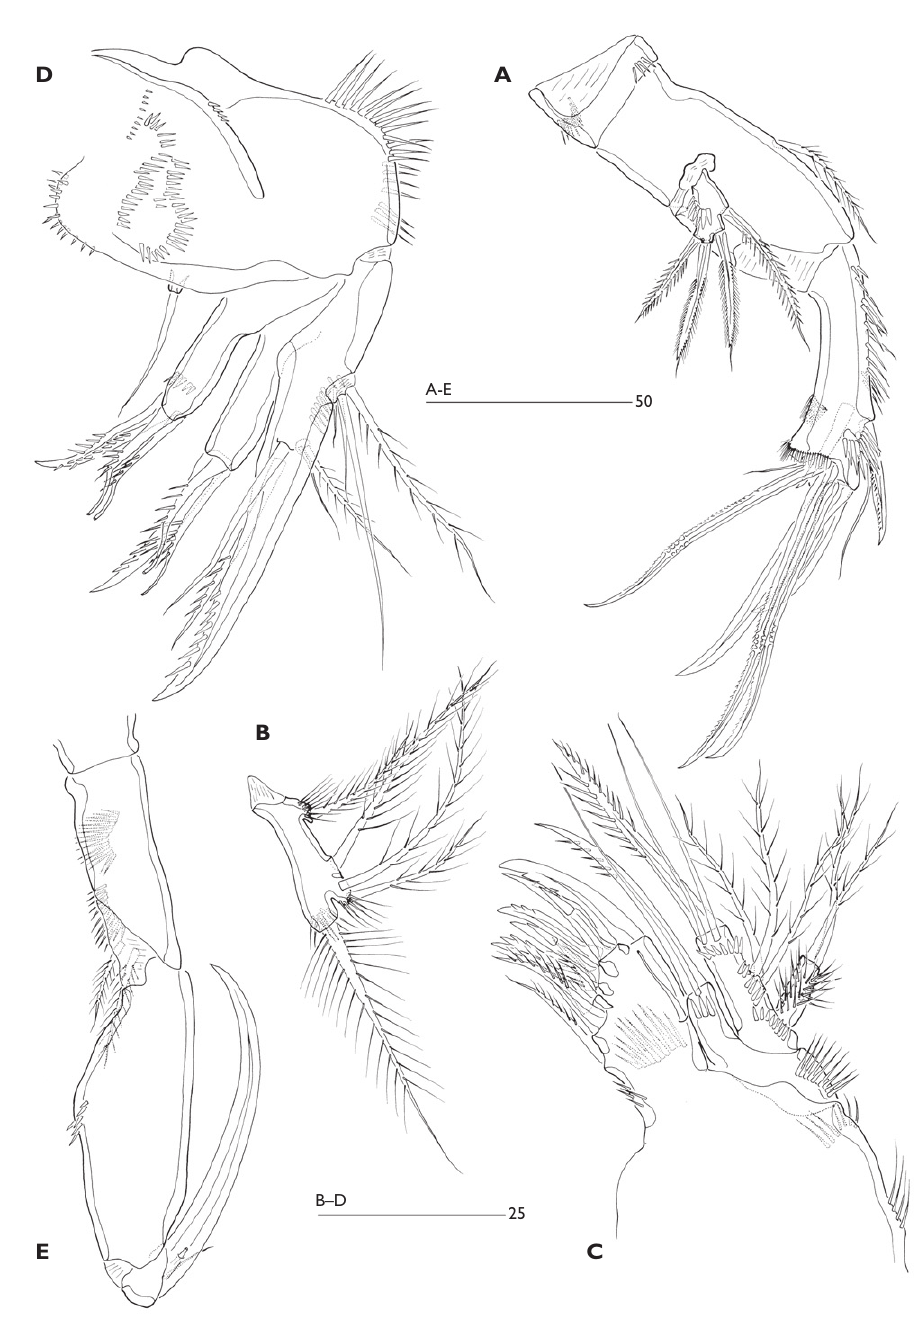
Figure 3. Marbefi a carthyi (Hamond, 1968), comb. n. ( ♀ ): A antenna B mandibular palp C maxillule, anterior D maxilla, posterior E maxilliped,